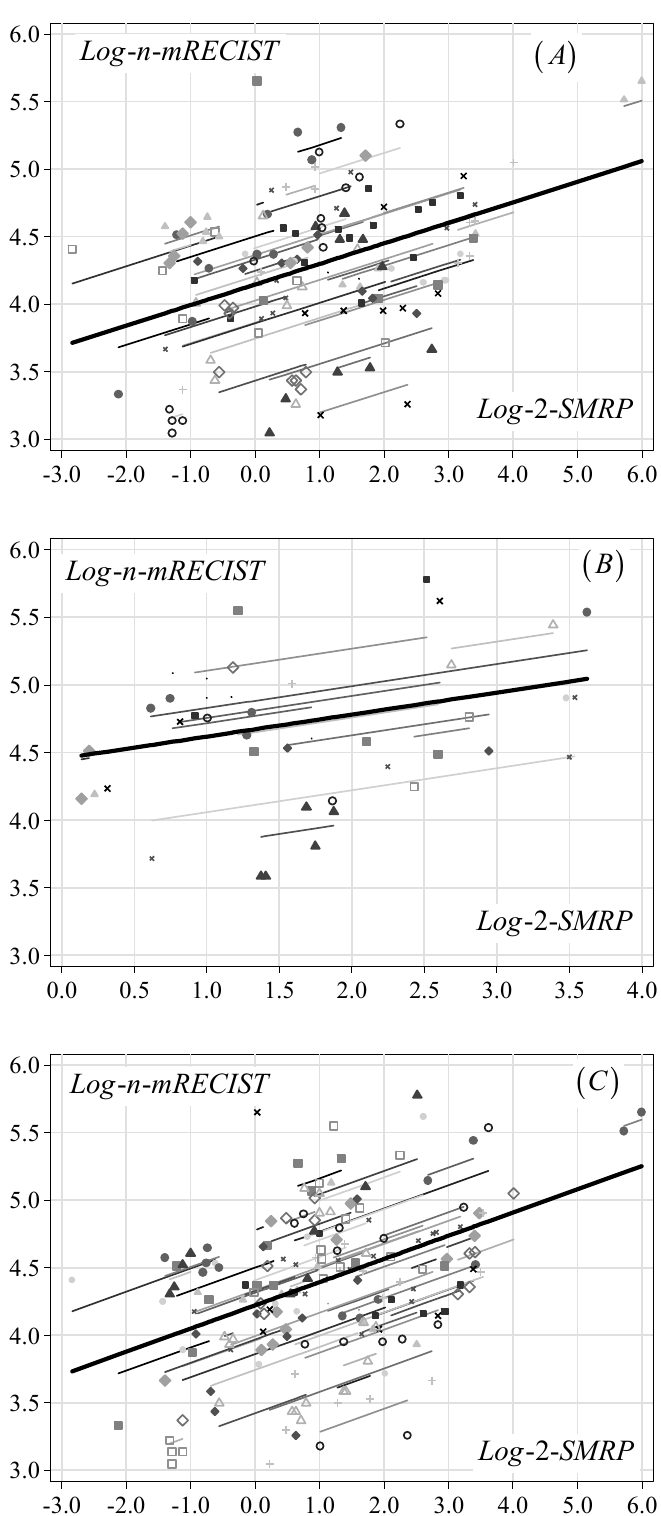
Figure 1. Association between mRECIST score and SMRP levels (double logarithmic scale) estimated through a normal random-effects regression in the AL cohort ( A ), SP cohort ( B ) and both cohorts ( C ). Note: mRECIST: modified RECIST; SMRP: soluble mesothelin-related peptides; log-n: natural logarithm; log-2: base-2 logarithm. Symbols: observed patient-specific levels of log-n-mRECIST score and log-2-SMRP. Thin lines: patient-specific linear relationships between log-n-mRECIST score and log-2-SMRP levels. Thick lines: overall relationship obtained as an average across all